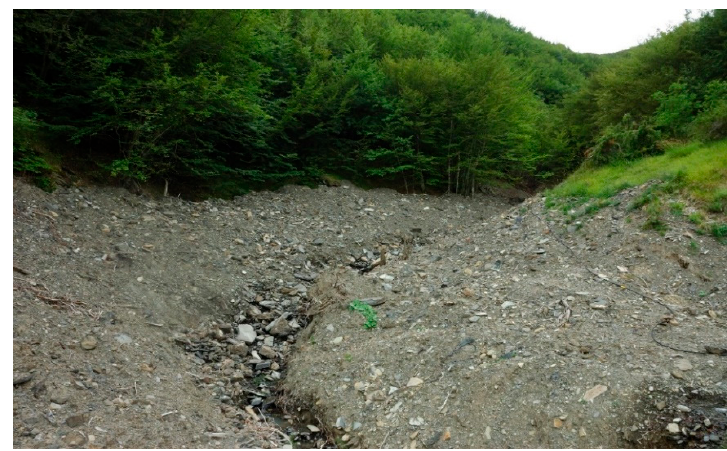
Figure 11. Examples of high-discharge flow deposits, emplaced in a narrow riverbed tract.